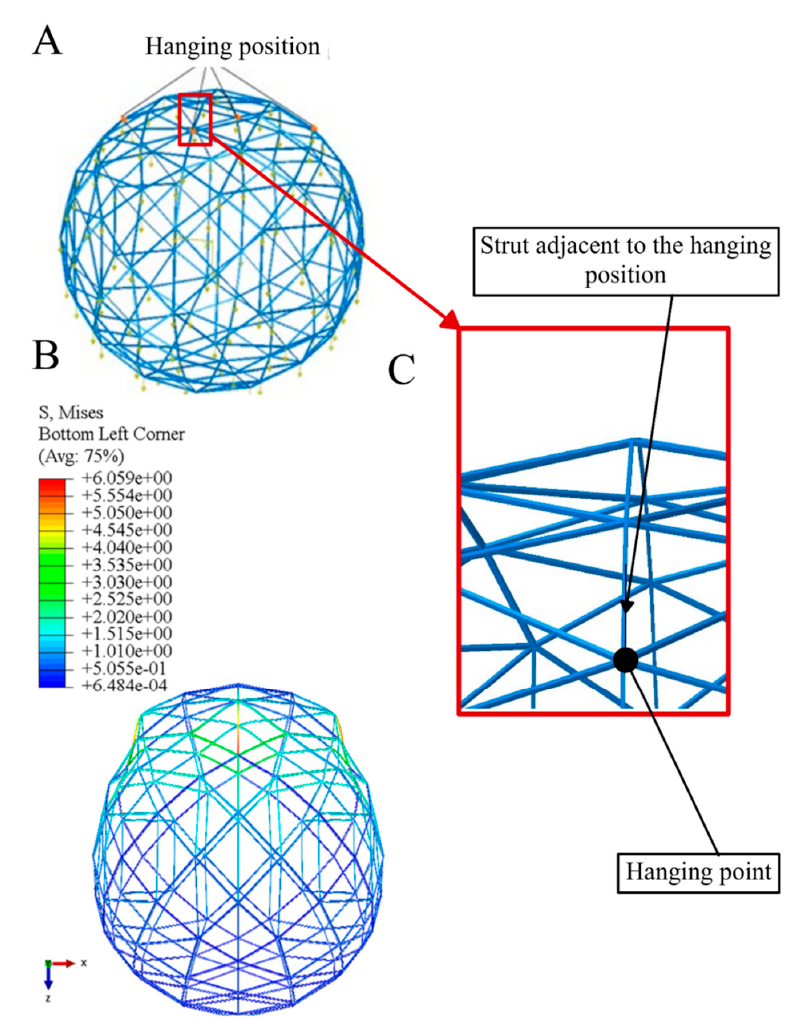
Figure 4. A 10-year Abaqus FEA time-dependent deformation of a 20-m-diameter aquacultural rigid frame structure made from WPC struts. ( A ) Non-deformed structure in four-point hanging position, and ( B ) deformed shape after ten years. ( C ) the strut adjacent to the hanging point.